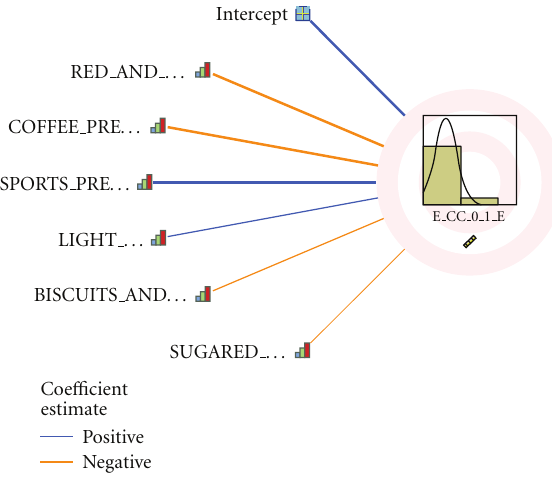
Figure 2: Influence in GDM of each factor according to the automatic lineal regression model. “Positive” means lower risk for GDM and “Negative” means greater risk for GDM. The width of the line is directly proportional to the magnitude of the e ff ect and the significance.